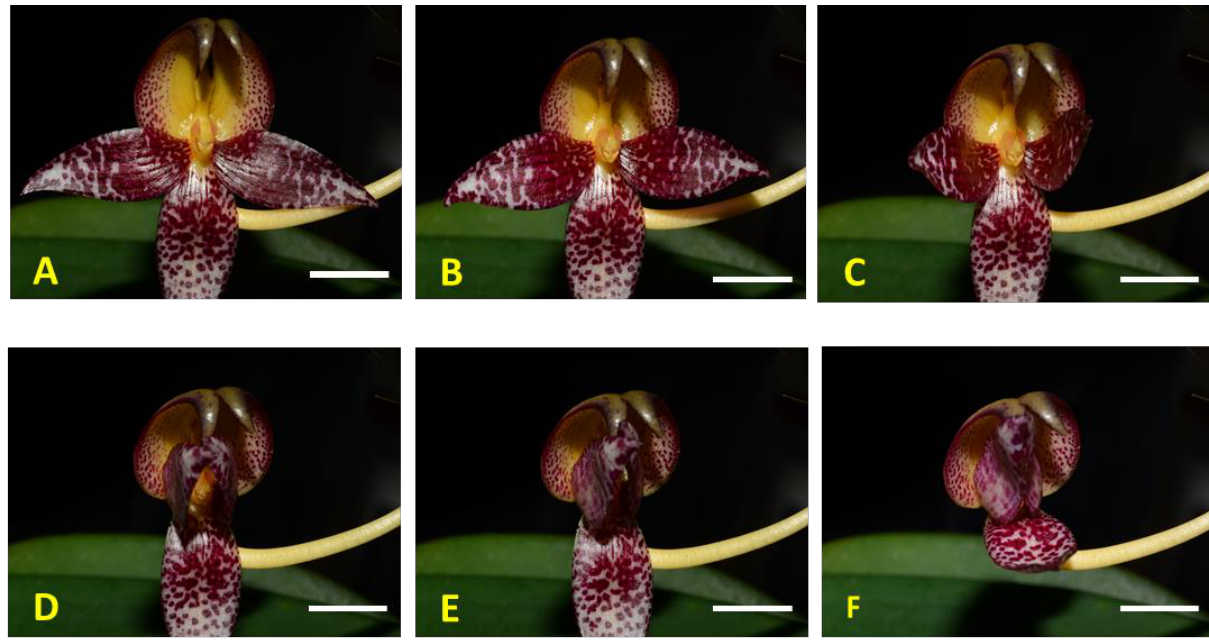
F IGURE 3. Closing of Bulbophyllum praetervisum flower for the night when not pollinated. (A) Process initiated with petal tips moving forward - at ca 15:00 h. (B) Tips of column wall teeth moved towards each other - at 18:00 h. (C) Tips of teeth overlap slightly and petal tips in front of the column – at 18:30 h. (D) Teeth overlap and petal tips touching over column and below lateral sepal tips – at 19:00 h. (E) Column hidden and medial sepal began folding – at 20:00 h. (F) Medial sepal moved to a horizontal position – at 23:00 h.